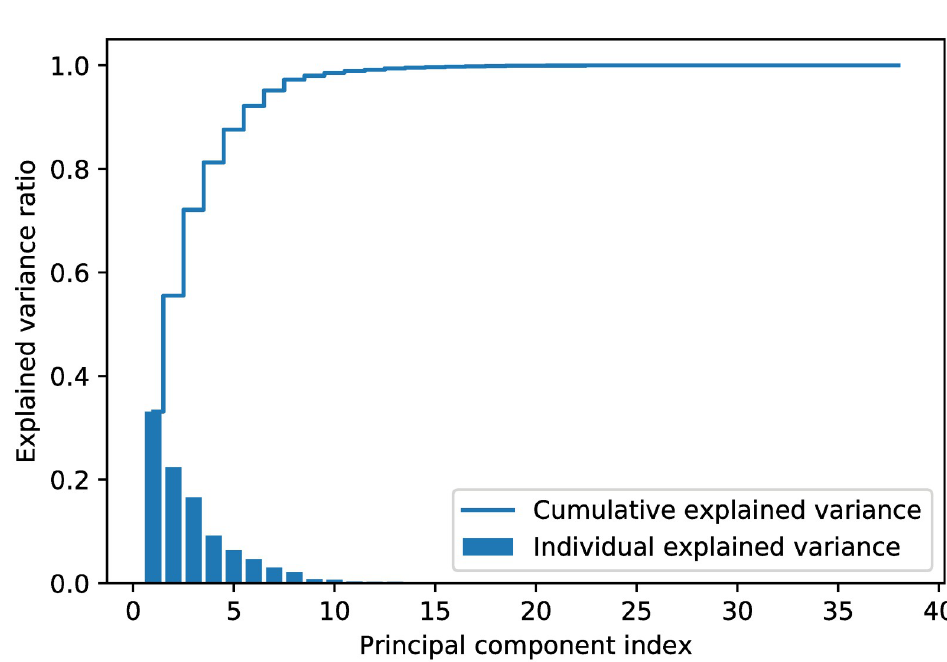
Fig 11. Explained variance ratio for the NHANES dataset.